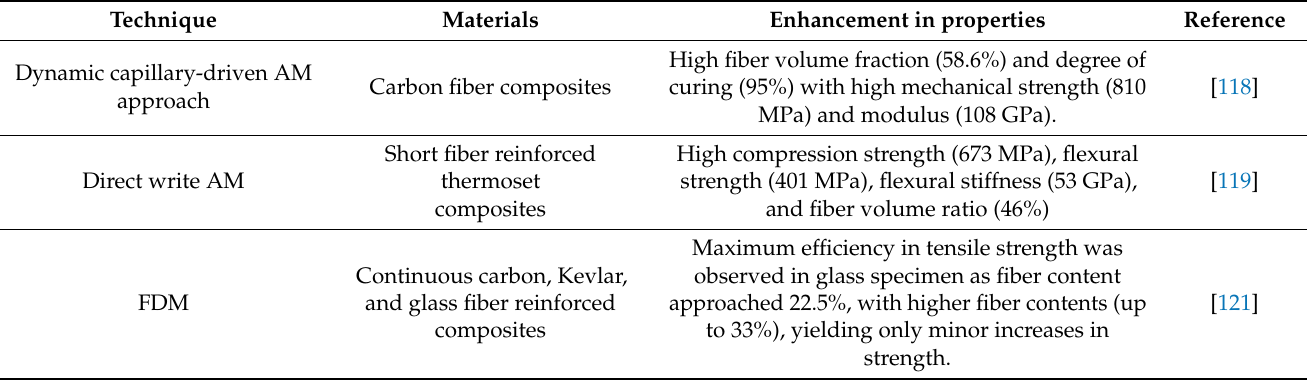
Table 5. Techniques used and properties enhanced in fiber reinforced polymer